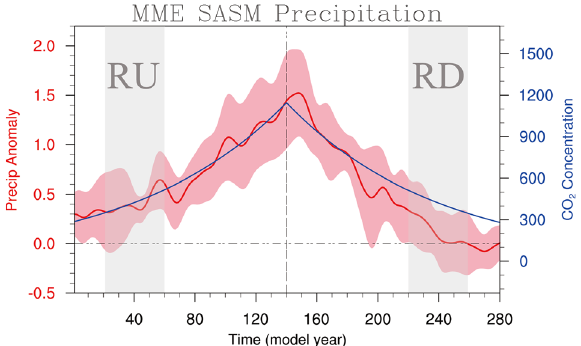
Fig. 2 The evolution of SASM precipitation in the idealized CO 2 ramp-up and ramp-down experiments. Time series of the CO 2 concentration (blue line; unit: ppm) and rainfall (red line; unit: mm day − 1 ) anomaly compared to PI. Pink shadings indicate the ensemble spread of the seven models. A 3-point (1/4,1/2,1/4) fi lter with 40 times is used to remove interannual variability. The vertical dotted line denotes the CO 2 peak year (Year 140). Two gray shadings in Year 21 – 60 (RU) and Year 220 – 259 (RD) indicate the two 40-year periods with the same average CO 2 concentration during the ramp- up and ramp-down